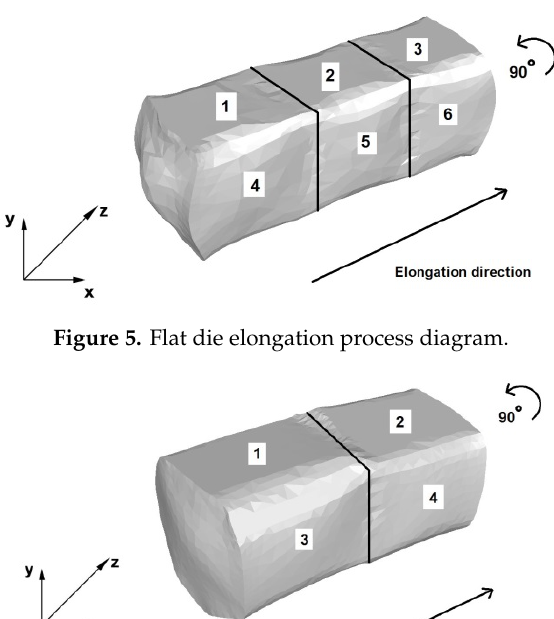
Figure 4. Shape and dimensions of rhombic-trapezoid dies used for AZ91 magnesium alloy forging.